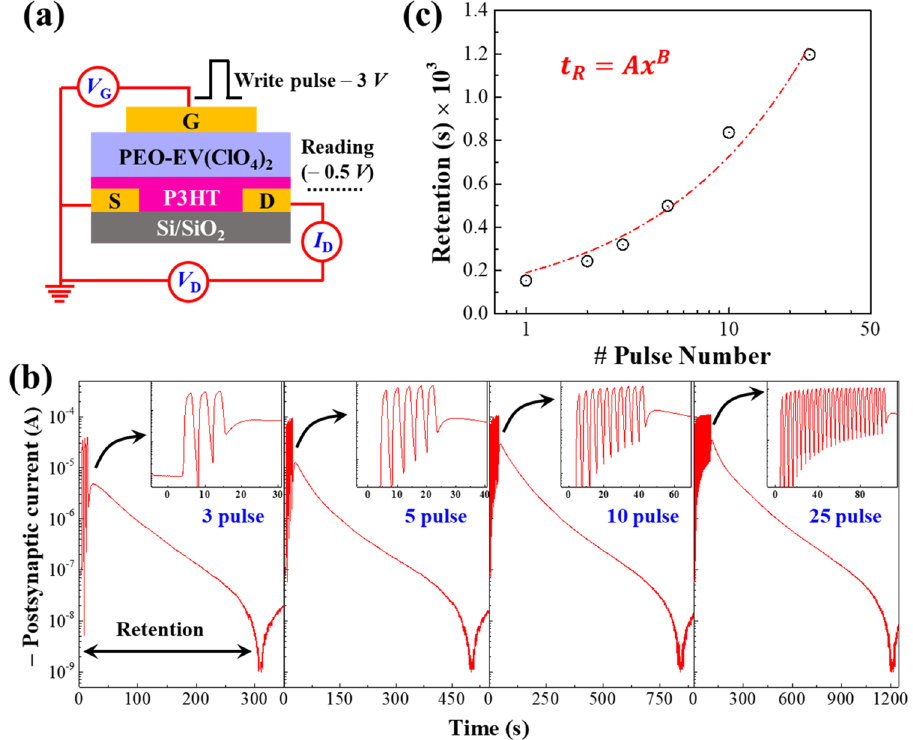
Figure 2. ( a ) Schematic diagram of the mem T devices to study EPSC potentiation and retention by varying presynaptic voltage pulse numbers up to 25 pulses. ( b ) Potentiation and retention of EPSC result with increasing number of consecutive presynaptic pulses (− 3.0 V, 2 s) at the gate. ( c ) Dependency of the relaxation time in terms of natural decay of EPSC in open circuit mode to the off-conducting state on number of consecutive pulses applied at the